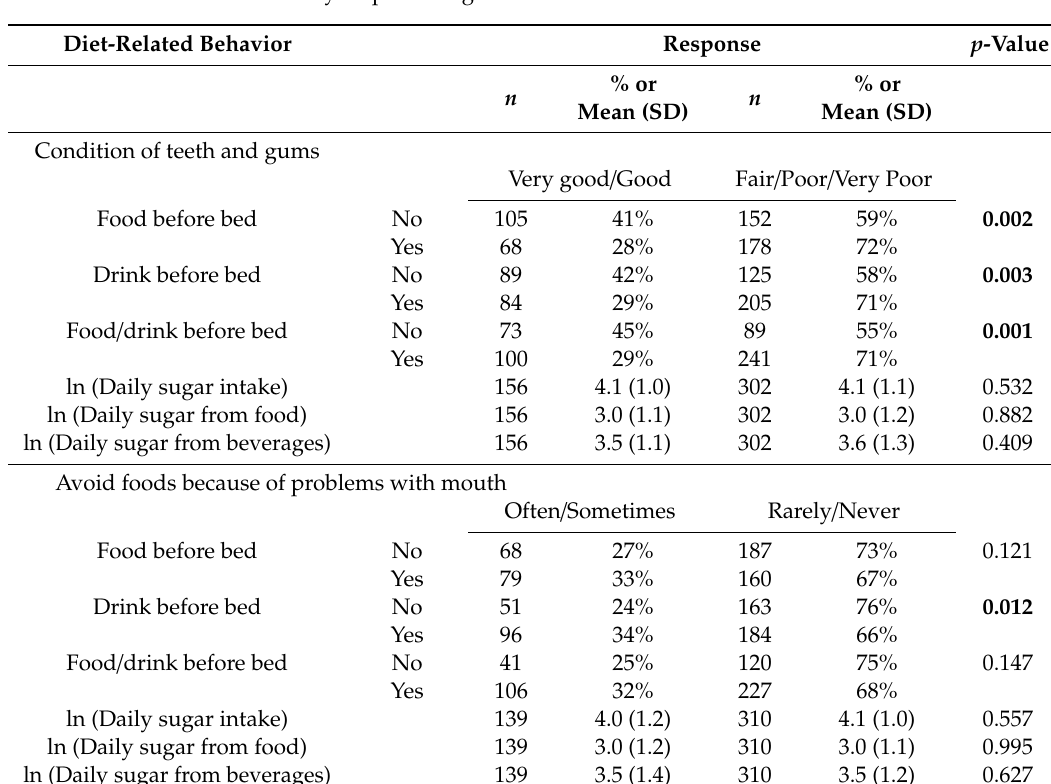
Table 3. Bivariate analyses predicting dental outcomes based on diet-related